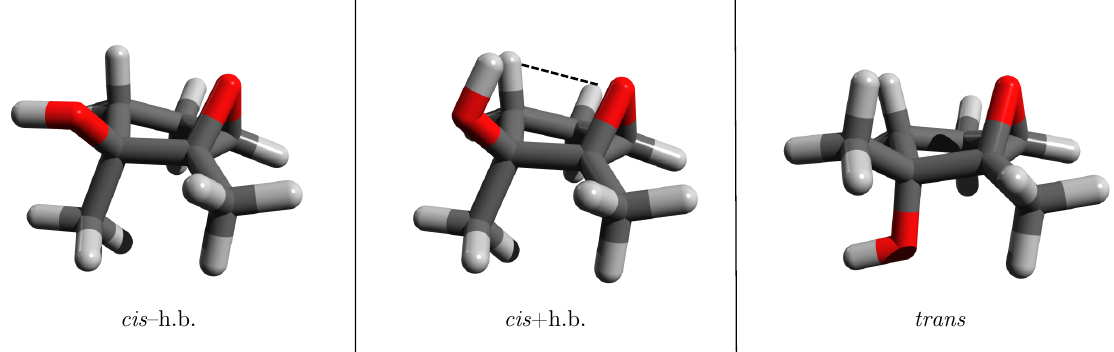
Figure 2. Three structural motifs of the 1,2-dimethyl-2,3-epoxycyclopentanols examined in Reference [21]: cis isomer without hydrogen bond ( left ), cis isomer with hydrogen bond ( center ), trans isomer ( right